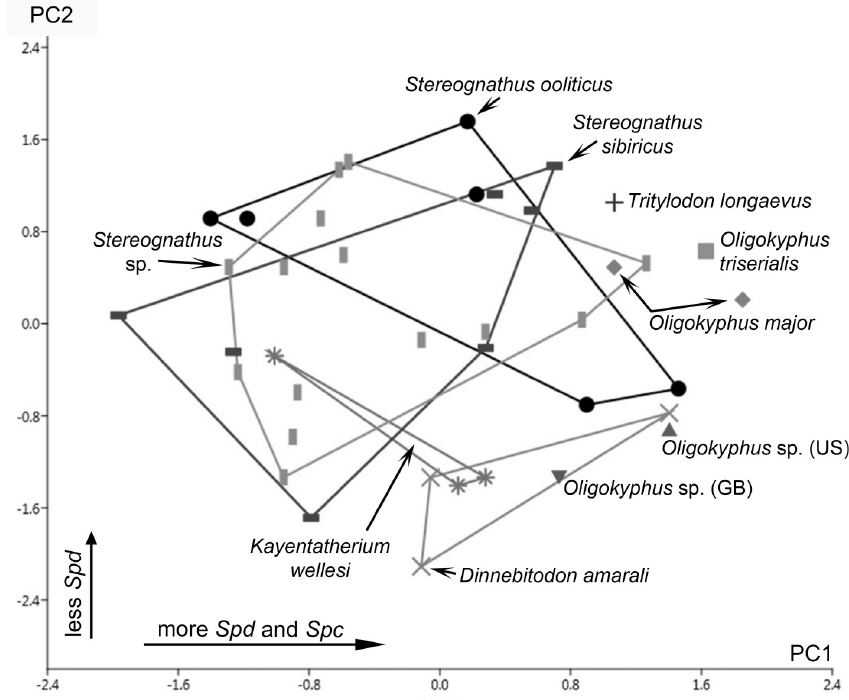
Fig 5. Scatter plot of principle components 1 and 2 on 3D surface texture parameters. 3D surface texture parameters used are: pit void volume ( Vvv in μ m 3 / μ m 2 ), mean dale area ( Sda in μ m 2 ), peak density ( Spd , 1/ μ m 2 ) and arithmetic mean peak curvature ( Spc , 1/ μ m). Convex hulls embrace the areas taken by each taxon (for taxa with n > 2); symbols represent individual